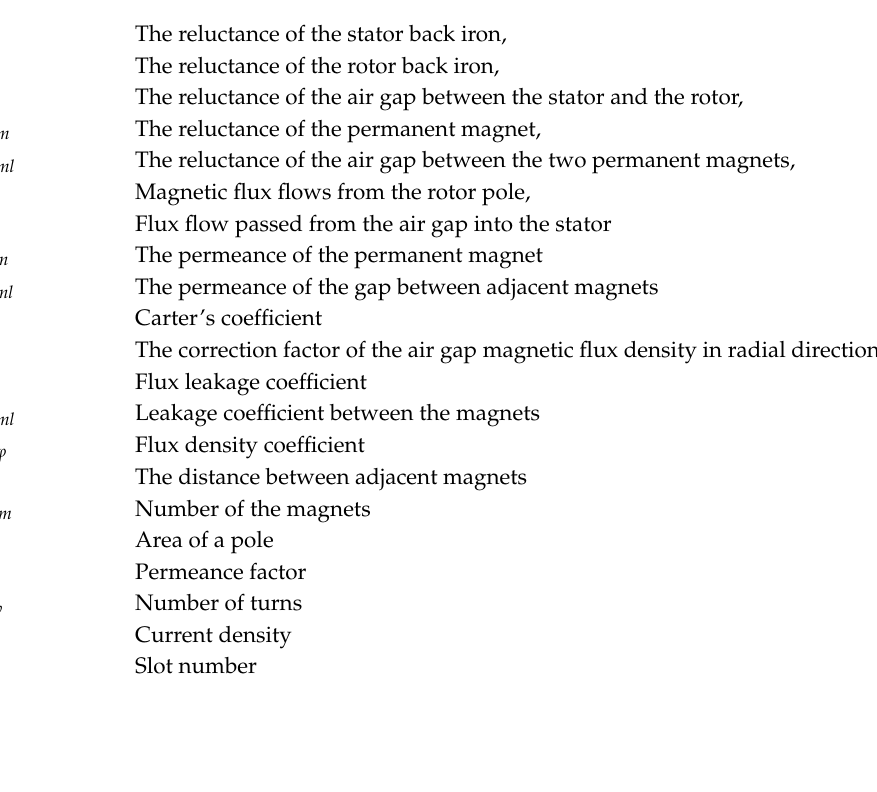
Table 5 in terms of air gap magnetic flux density, back EMF, and torque characteristics. The 3D-FEA and MAGEC results validate each